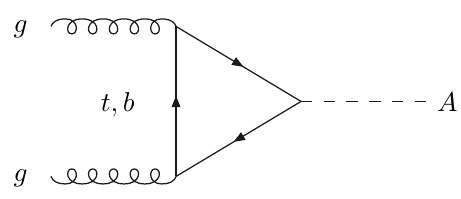
Figure 1 . Typical diagram contributing to gg → A at lowest